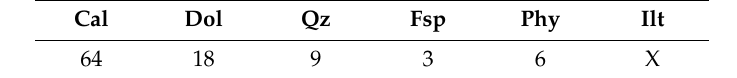
Table 4. XRD analysis of the samples from the central segment of the Baza Fault at the Barranco del Agua gully (west section). The distance corresponds to the distance from fault, which is also plotted on the x-axes of the plots in Figure